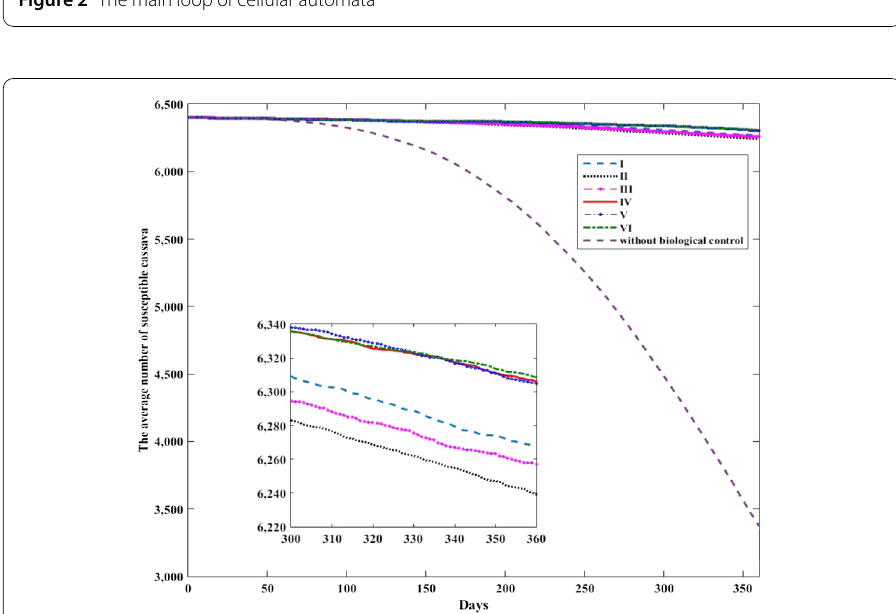
Figure 2 The main loop of cellular automata